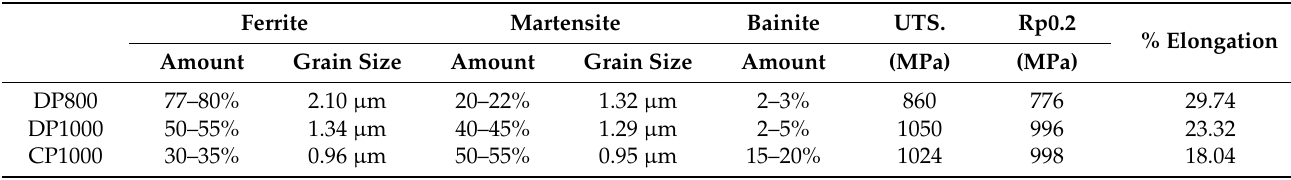
Figure 5. SEM images of the surfaces of ( a ) DP800 steel ( c ) DP1000 steel, ( e ) CP1000 steel, and cross-sections of ( b ) DP800 ( d ) DP1000, and ( f ) CP1000 steel sheets. The orange, blue and green arrows represent ferrite, martensite, and bainite, respectively. Table 2. Summary of the microstructural (phase fraction, average grain size) and mechanical (tensile strength and % Elongation) data of the